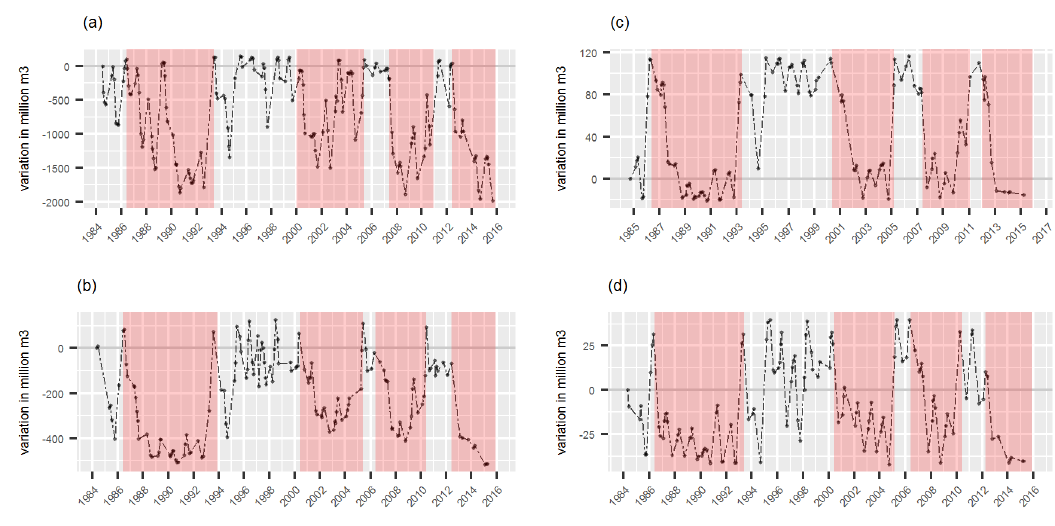
Figure 10. Volume variation patterns: ( a ) Lake Oroville, ( b ) Lake McClure ( c ) H.V. Eastman Lake ( d ) Hensley Lake.